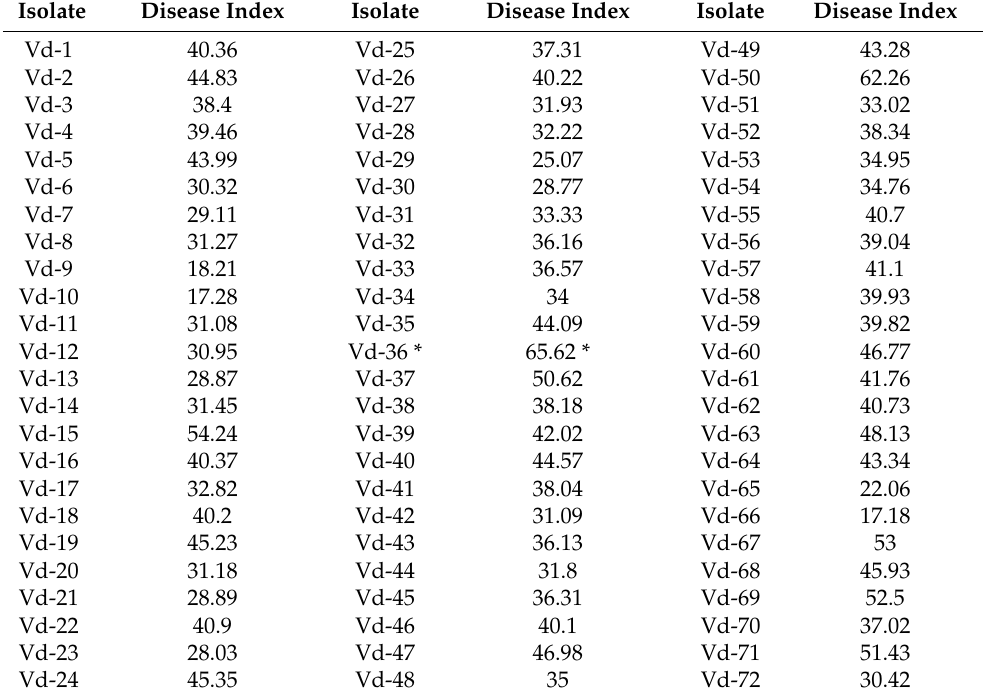
Table 1. Pathogenicity of V. dahliae isolates.